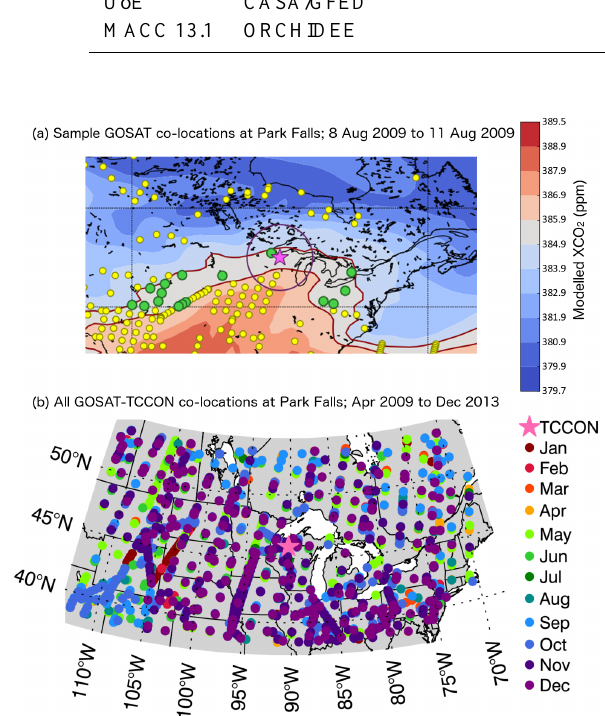
Figure 2. (a) An example of the GOSAT-TCCON co-locations us- ing the NOAA/Basu technique (Guerlet et al., 2013a) at Park Falls TCCON station (Wisconsin, USA). All GOSAT/ACOS soundings from 8 to 11 August 2009 are shown with filled circles. The dy- namical criterion based on the modelled XCO 2 fields and a 0.5ppm tolerance from the value at the TCCON location limits the num- ber of co-located satellite soundings (green circles). The soundings marked with yellow symbols did not pass the co-location criteria. (b) All co-located GOSAT/ACOS soundings from April 2009 to December 2013 at the Park Falls TCCON, coloured according to the month of